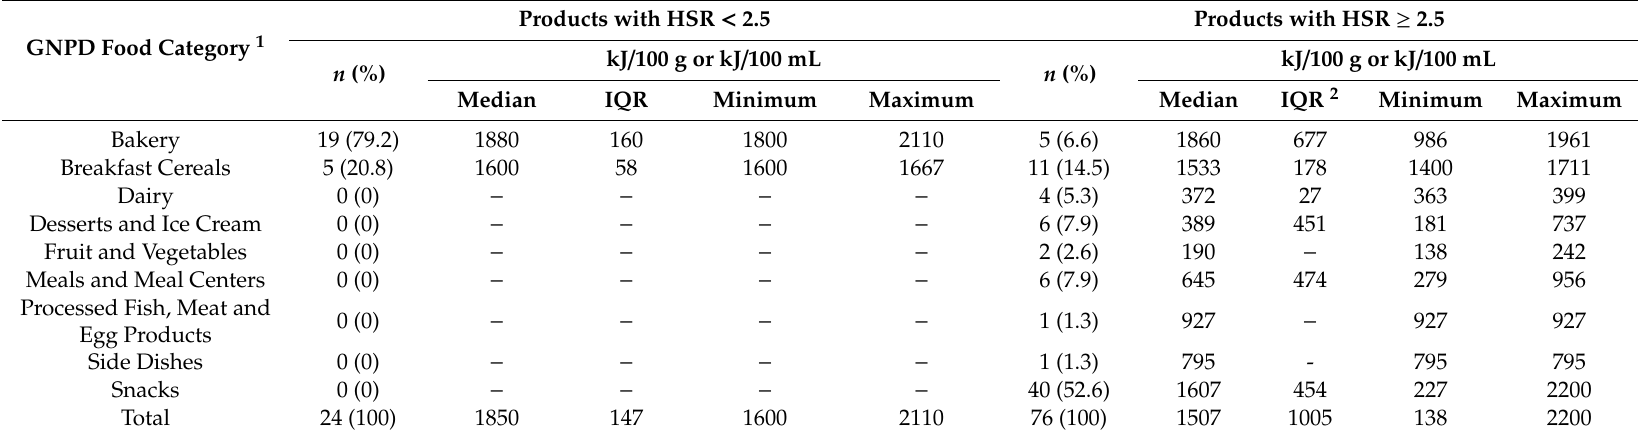
Table 3. The energy density of products with a Health Star Rating (HSR) < 2.5 and with an HSR ≥ 2.5 by Global New Products Database (GNPD) food category.